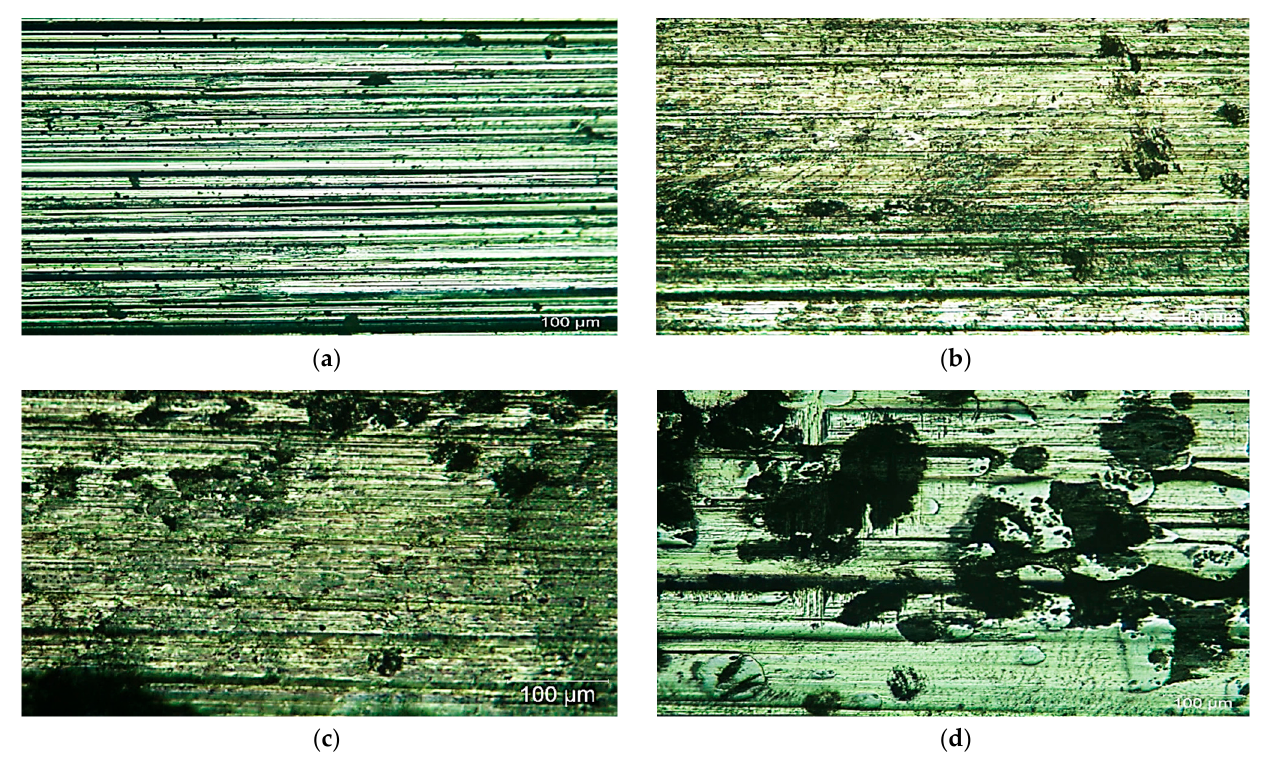
Figure 21. Optical images of worn surface morphologies of ( a ) as-cast sample, ( b ) sample 1, ( c ) sample 2, and ( d ) sample 3.